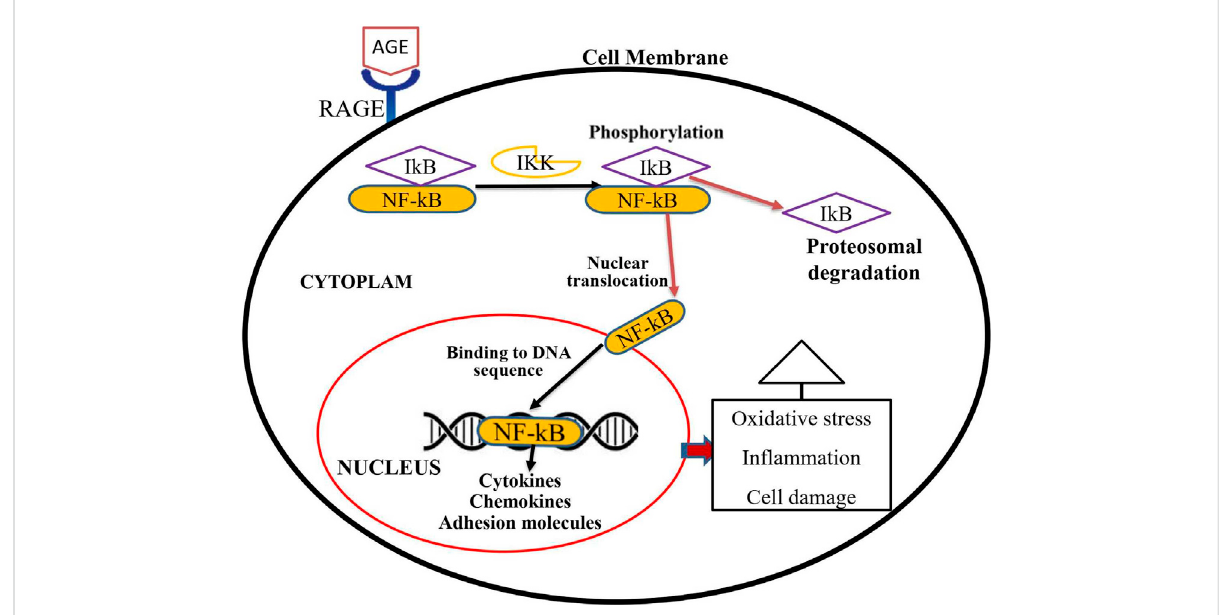
FIGURE 1 Activation process of NF- κ B transcription factor through an AGE-RAGE signaling pathway. Activation of RAGE through AGE interaction transduces a signal for the phosphorylation of IkB by IKK. Phosphorylated IkB then could be detached from the cytosolic NF-kB transcription factor. Multiplegenessuchascytokines,chemokines,andadhesionmoleculesareactivatedwhenactiveandfreeNF-kBtranslocateintothenucleus.These proteins trigger oxidative stress, in fl ammation, and cellular damage, all of which contribute to diabetic